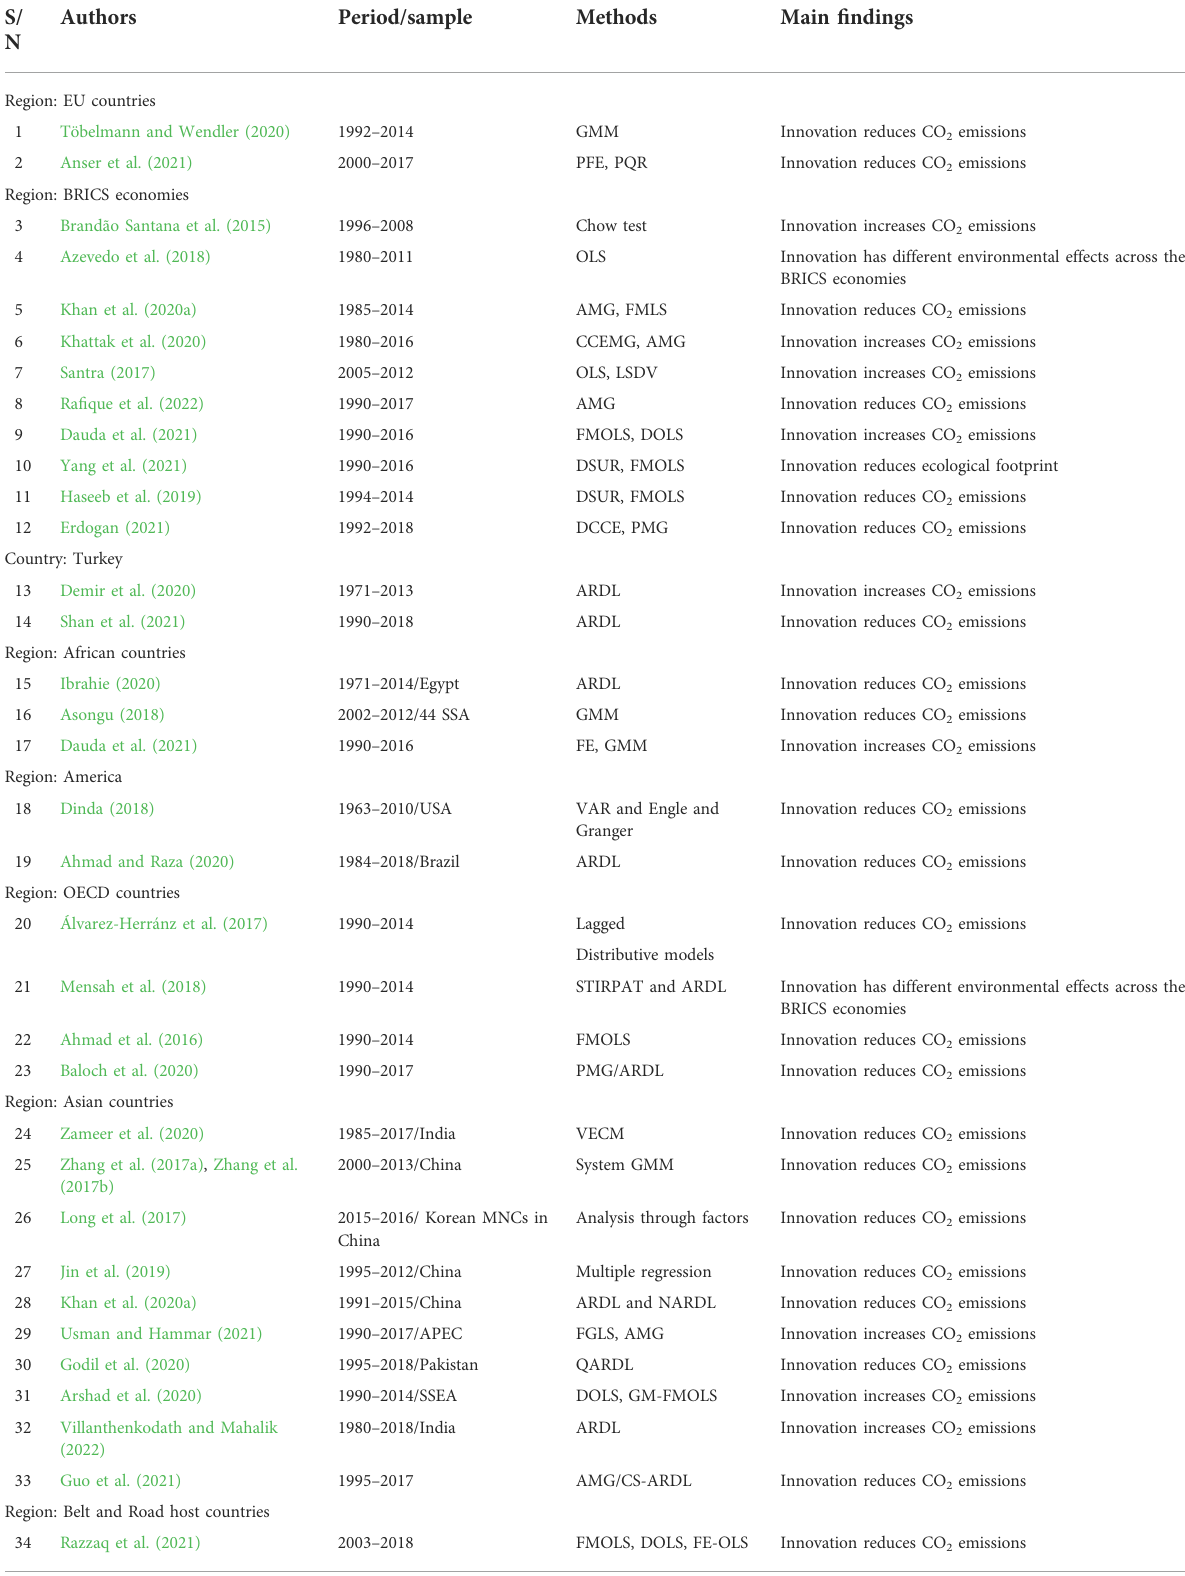
TABLE 1 A summary of the selected articles on the innovation – CO 2 emissions nexus based on different